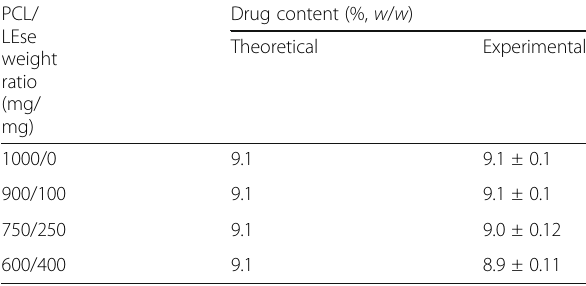
Table 2 Characterization of PL-incorporated nanofiber mats PCL/ LEse weight